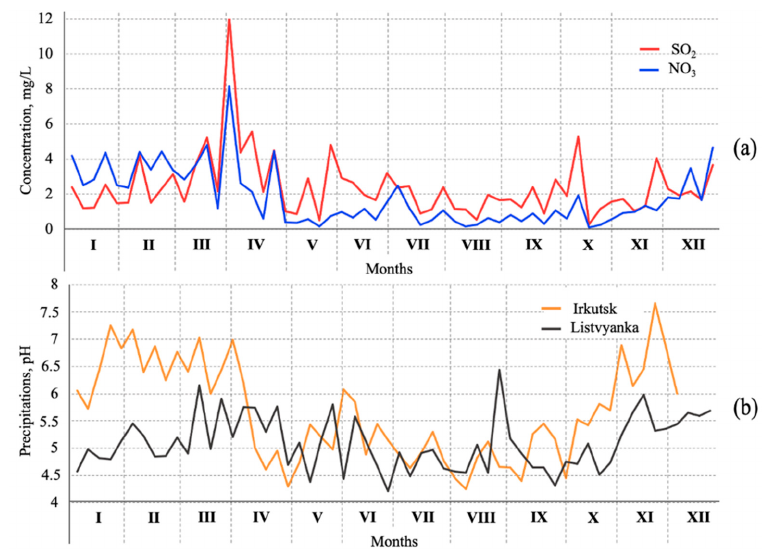
Figure 6. Seasonal variation in the concentrations of sulfates and nitrates in precipitation at the Listvyanka station ( a ) and pH values in precipitation in Irkutsk and Listvyanka ( b ) in 2020.